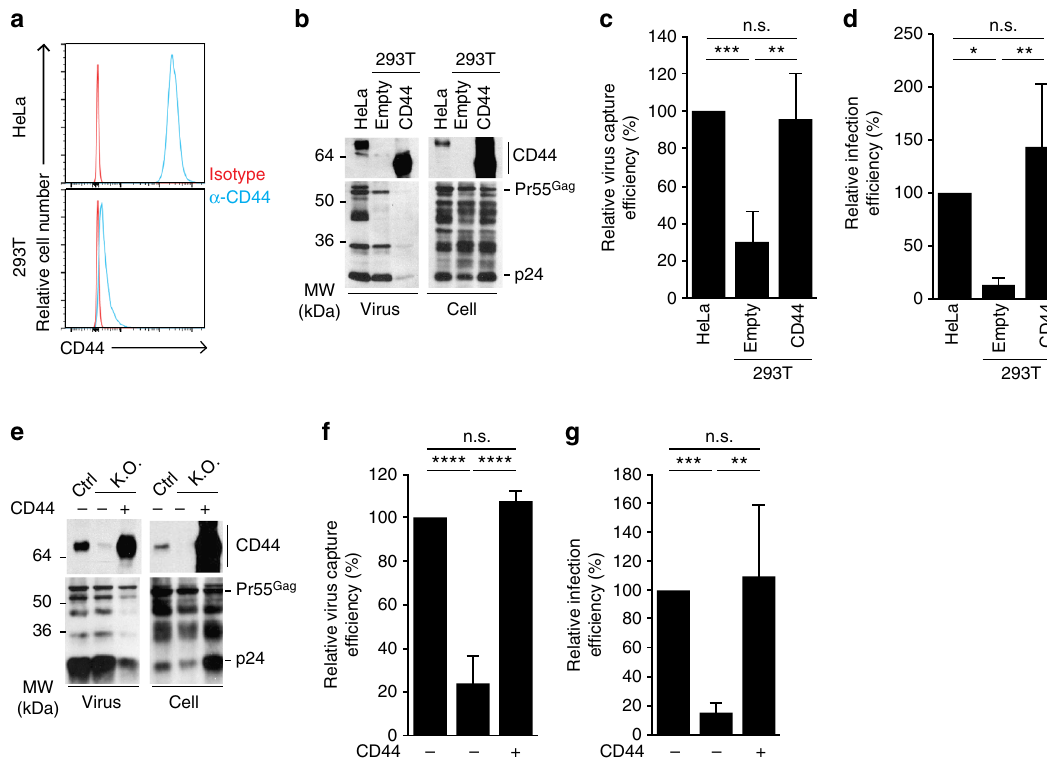
Fig. 6 The incorporation of CD44 into virions is required for ef fi cient FRC-mediated trans-infection. a Flow cytometry analysis of CD44 expression on HeLa and 293T surfaces. b Western blot analysis of CD44 incorporation into virus particles, which were produced by HeLa and 293T cells, latter of which had been transfected with empty or CD44-encoding expression plasmids. CD44 (top) and HIV-1 proteins (bottom) are shown for virus (left) and cell (right) lysates. c HIV-1 NL4-3 generated as in b was compared for ef fi ciencies of virus capture by lnFRCs. lnFRCs were cultured in the presence of HIV-1 NL4-3 (7.6 ng p24) for 2 h and washed extensively. The amount of virus captured by lnFRCs was quanti fi ed by p24 ELISA assays. Relative ef fi ciencies in comparison to HeLa-derived virus are shown. d The viruses examined in c were compared for the ef fi ciencies of lnFRC-mediated trans-infection of A3.01 T cells. lnFRCs were cultured in the presence of HIV-1 NL4-3 (7.6 ng p24) for 2 h, washed extensively, and cocultured with A3.01 T cells for 6 days. A3.01 T cells were analyzed for expression of Gag by fl ow cytometry. e Western blot analysis of CD44 incorporation into virus particles, which were produced by control (Ctrl), CD44-knocked out (K.O.), and CD44-reconstituted HeLa cells. CD44-knocked out HeLa cells were generated using a CRISPR-Cas9-based method. Control HeLa cells were prepared similarly except that pSpCas9(BB)-2A-Puro was used instead of pSpCas9(BB)-2A-Puro/CD44-gRNA. Reconstitution was achieved via transfection of the CD44 expression plasmid ( + ). Virus and cell lysates were analyzed as in b . f HIV-1 NL4-3 generated as in e was compared for ef fi ciencies of virus capture by lnFRCs. Virus capture was analyzed as in c . g The viruses examined in f were compared for the ef fi ciencies of lnFRC-mediated trans-infection of A3.01 T cells. Trans-infection was analyzed as in d . For experiments in c , d , f , and g , the data represent the mean ± SD of three ( f ) and four ( c , d , and g ) independent experiments. These experiments were performed using lnFRCs from one donor, but we observed similar results by using lnFRCs isolated from two other donors (total three donors). The p -values were determined using Tukey ’ s test following one-way ANOVA. * p